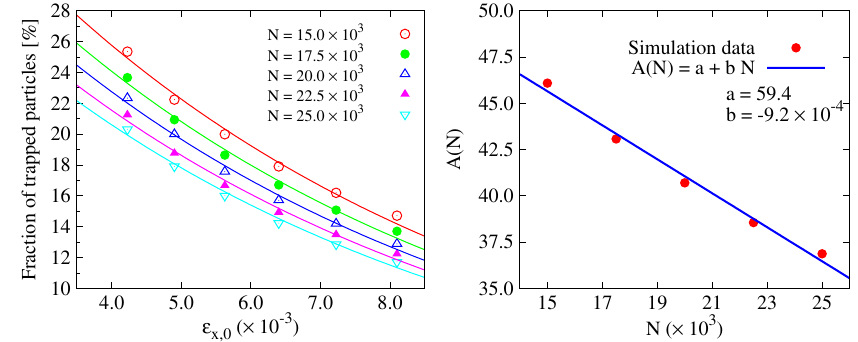
FIG. 7. (Color) Fit results of the fraction of trapped particles as a function of the total number of turns N with an exponential function (left). The amplitude of such an exponential is fitted as a linear function of N (right).